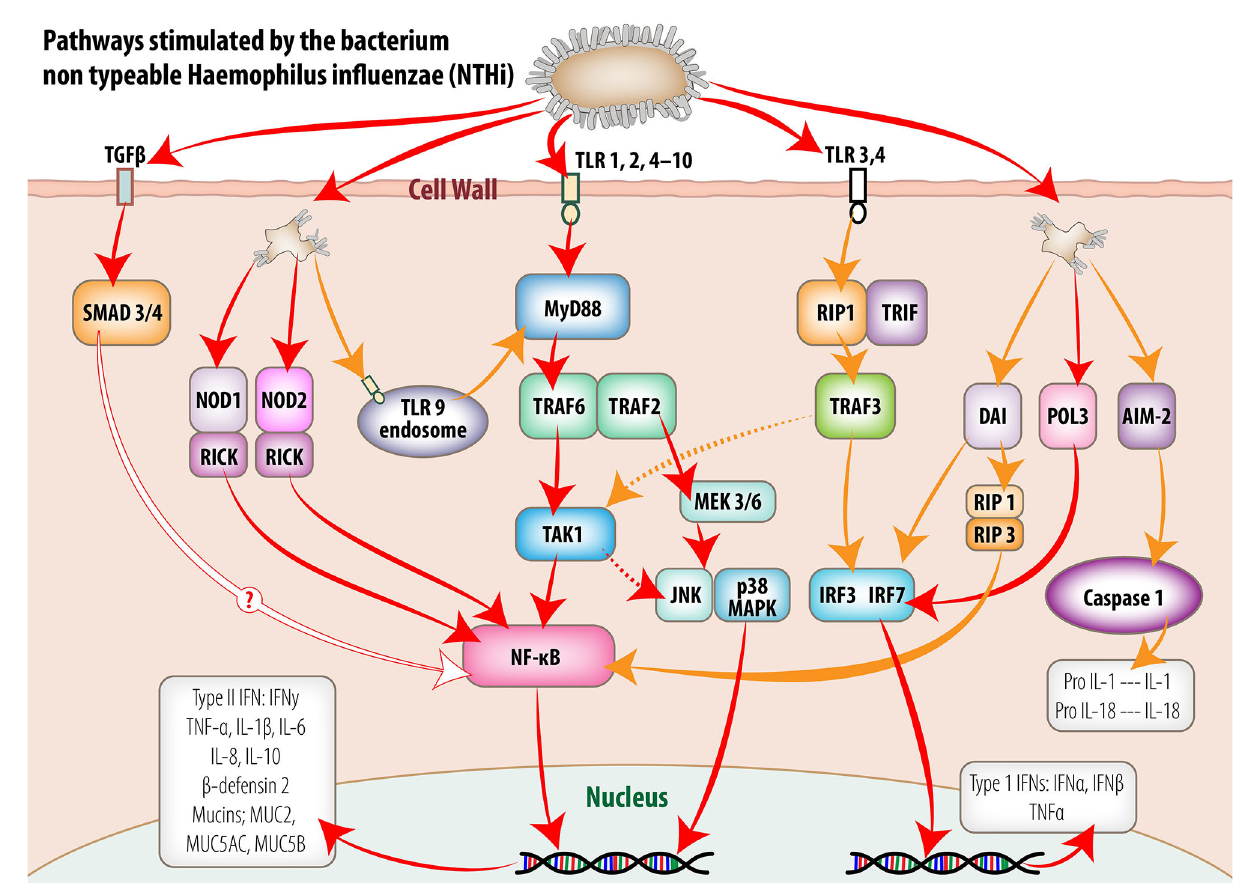
FIGURE 1 | Intracellular signaling pathways utilized by middle ear mucosa in response to stimulation by non-typeable Haemophilus in fl uenzae (NTHi). Pattern recognition receptors (PRR) detect conserved molecular signatures of invading microbes and facilitate activation of synthesis and secretion of downstream cytokine cascades. This fi gure schematically represents the signaling pathways activated by NTHi both at the cell membrane and within the cell cytoplasm of the middle ear mucosal cells. The information portrayed was extracted from published reports of experiments utilizing middle ear cell lines and middle ear epithelium and mucosa from animal models and human biopsy material. (Reproduced, with permission, Massa et al.,